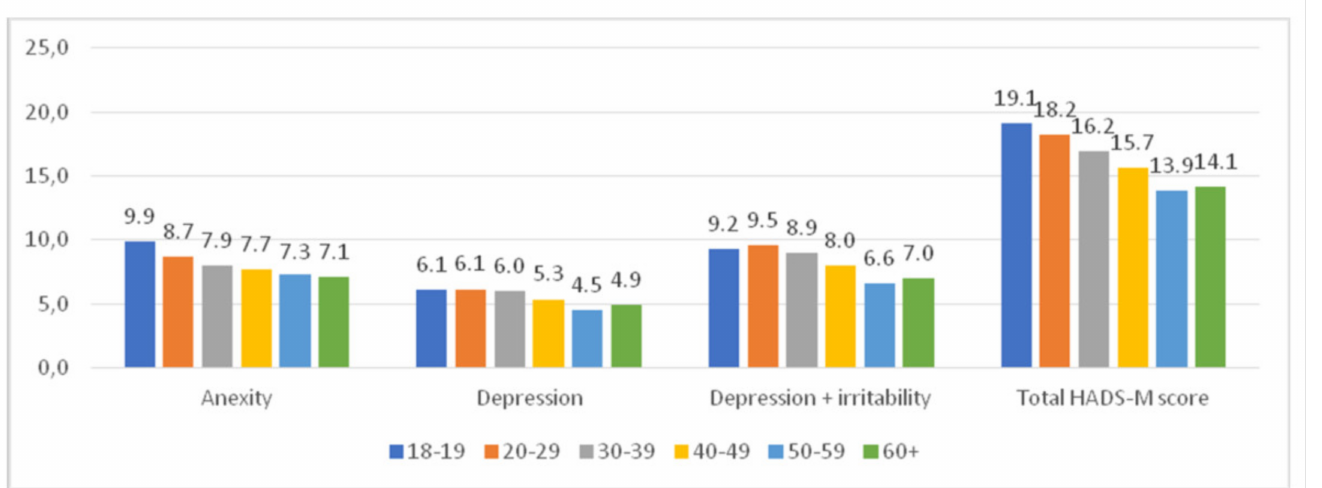
Figure 3. HADS-M score and the age of women.